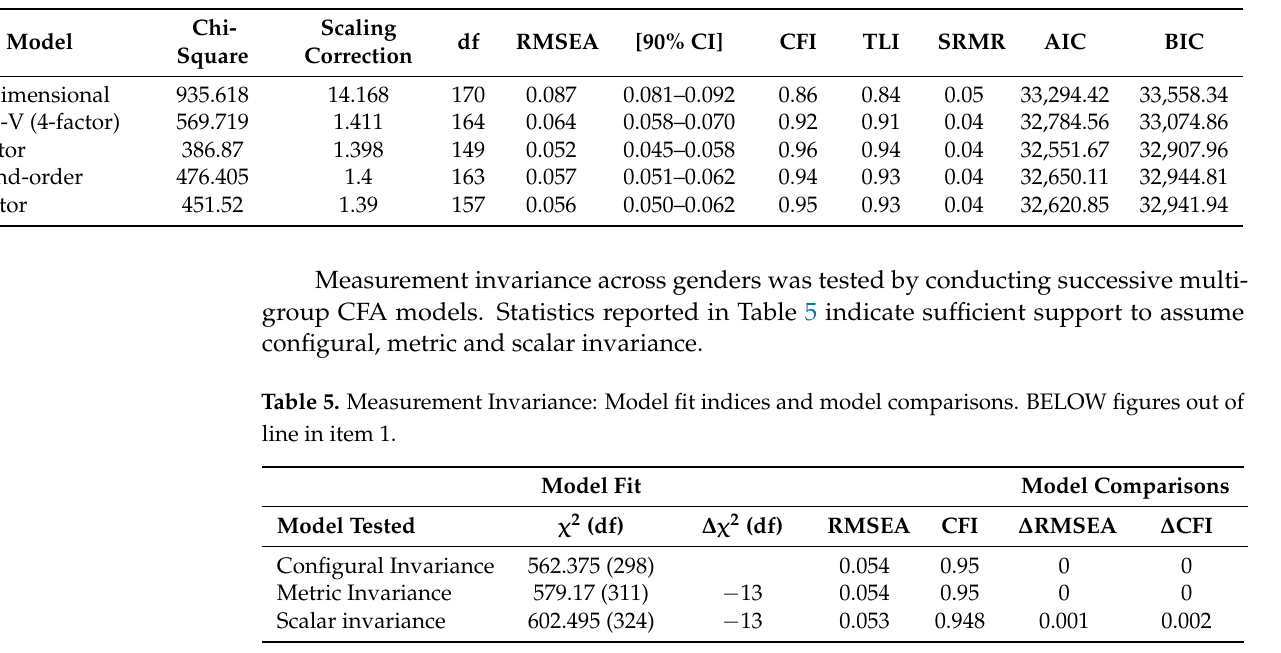
Table 4. Model fit for tested factor structure models.